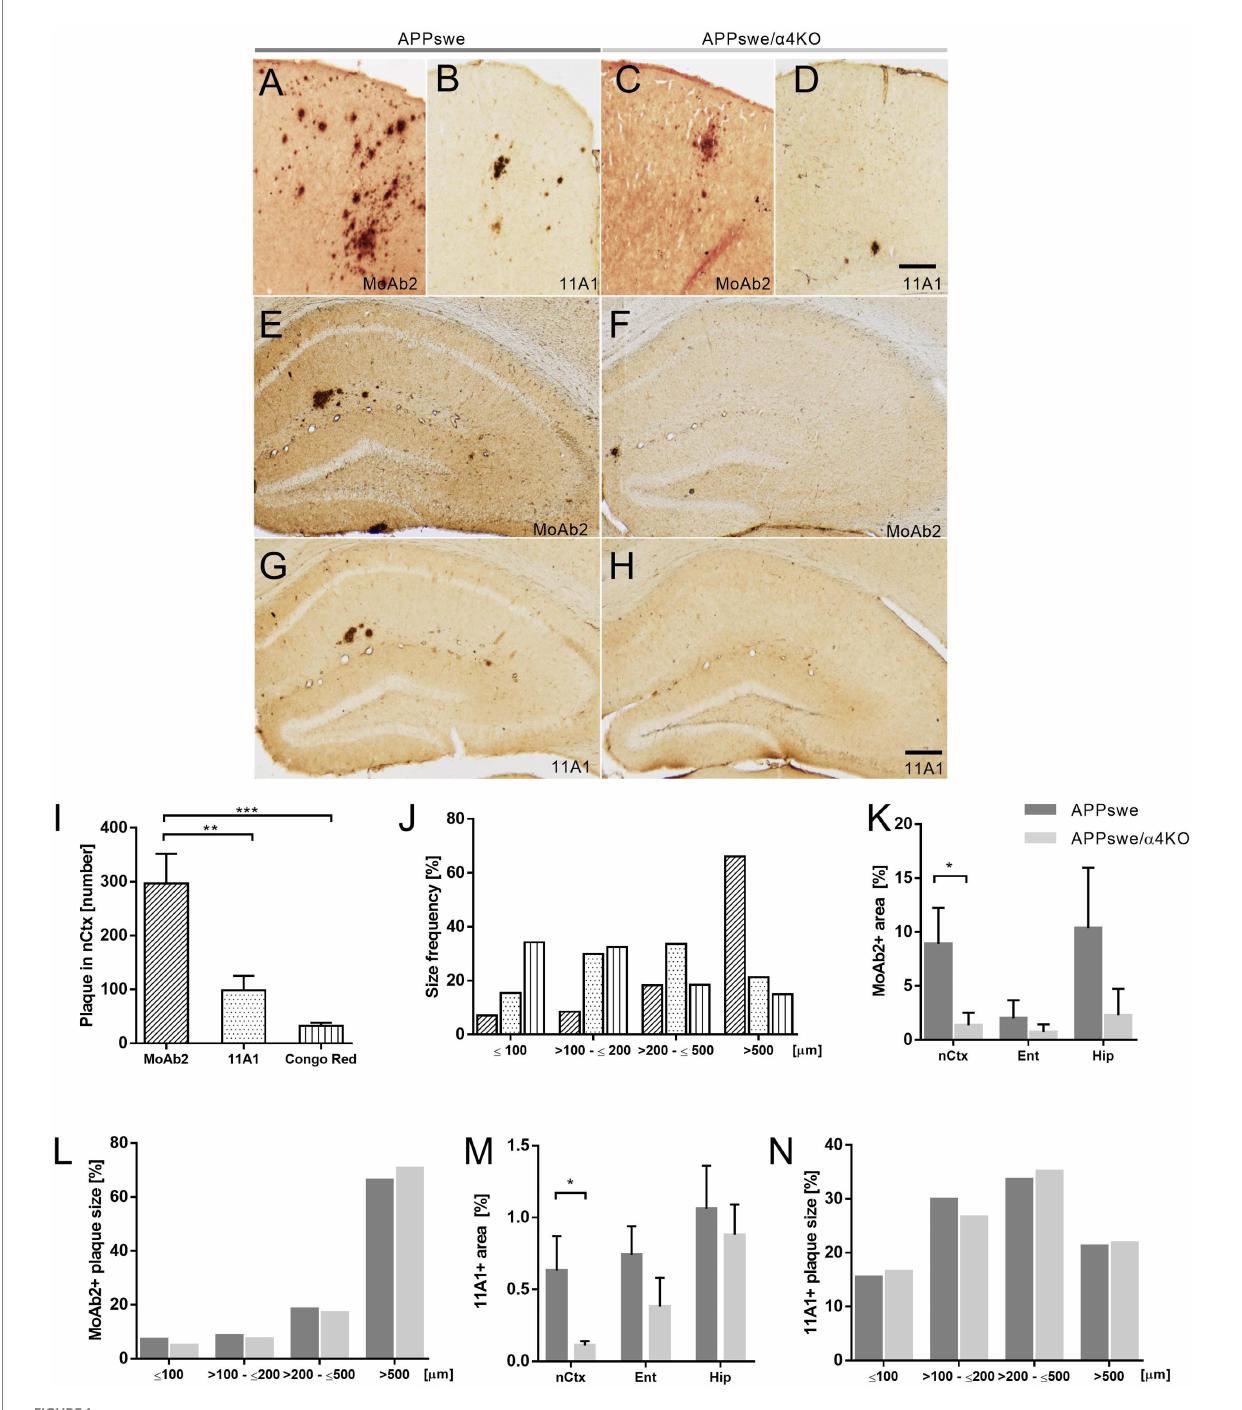
FIGURE 1 Amyloid plaque characterization and distribution in APPswe and APPswe/ α 4KO mice. (A–D) Representative images of MoAb2+ (A,C) and 11A1+ plaques (B,D) in the nCtx of APPswe (A,B) and APPswe/ α 4KO (C,D) 15 mo mice. (E–H) Representative images of MoAb2+ and 11A1+ plaques in the Hip of 15 mo APPswe (E,G) , and APPswe/ α 4KO (F,H) mice. Scale bar = 100 μ m. (I,J) Congo Red+, MoAb2+, and 11A1+ plaque count (I) and size distribution (J) in the nCtx of APPswe mice (** p < 0.01, *** p < 0.001). (K,N) Analysis of MoAb2+ plaque area in nCtx, Ent and Hip of APPswe and APPswe/ α 4KO mice (* p < 0.05). (L,N) MoAb2+ and (N) 11A1+ plaque size distribution in nCtx of APPswe (dark gray bar) and APPswe/ α 4KO (gray bar) mice. In I,K,L , data are shown as mean ± SEM and compared by one-way ANOVA followed by Bonferroni correction (I) and by Mann–Whitney U -test (K,M) . In J,L,N , frequencies are graphed as % by each group and compared by Chi square test. nCtx, neocortex; Ent, entorhinal cortex; Hip, hippocampal